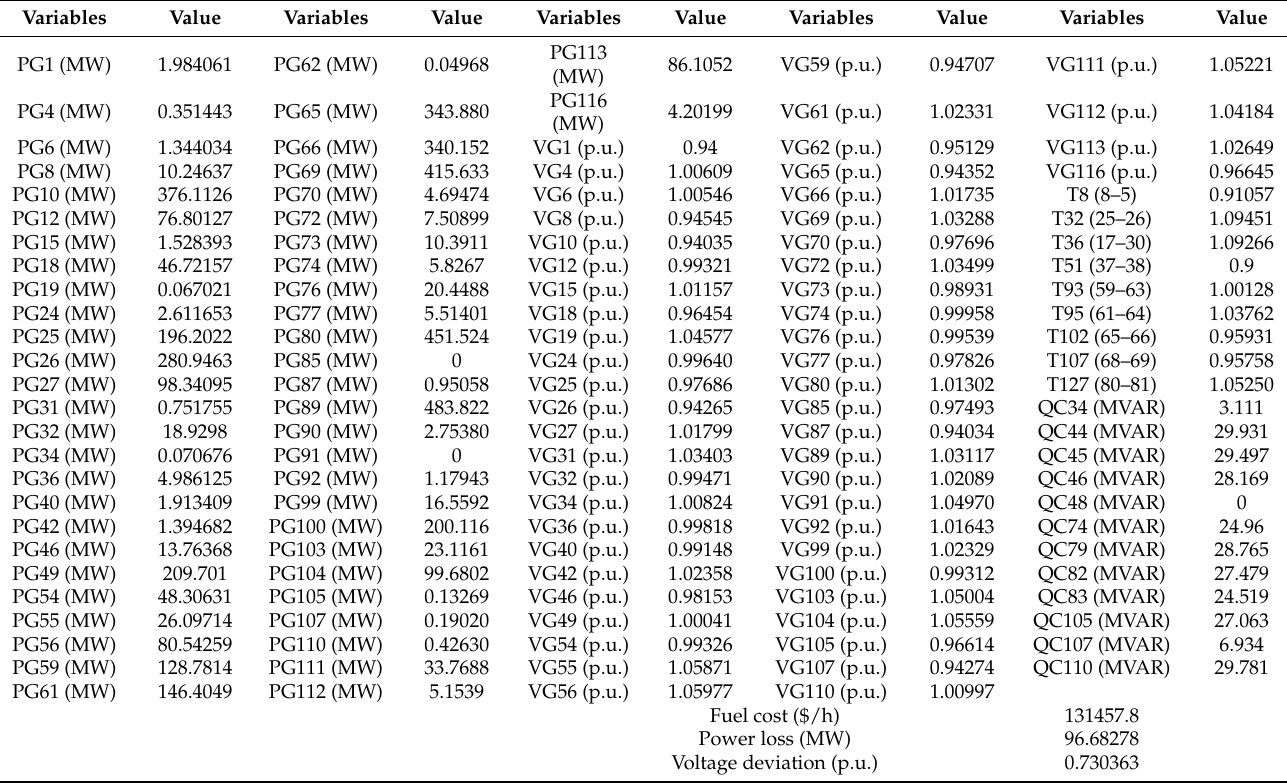
Table 9. Optimal settings of control variables for case 4 using MRao-2.